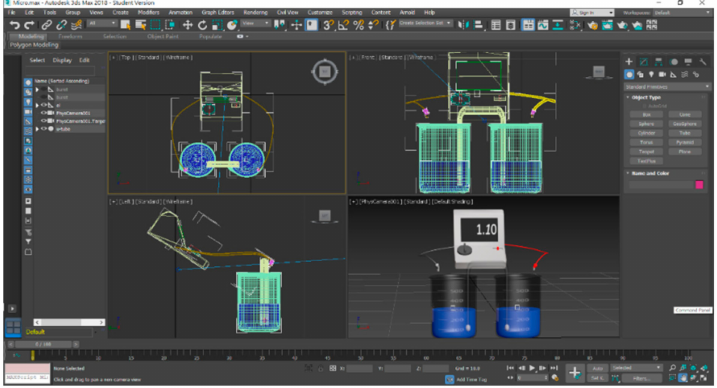
Figure 4. Using 3ds Max to develop the 3D models of laboratory